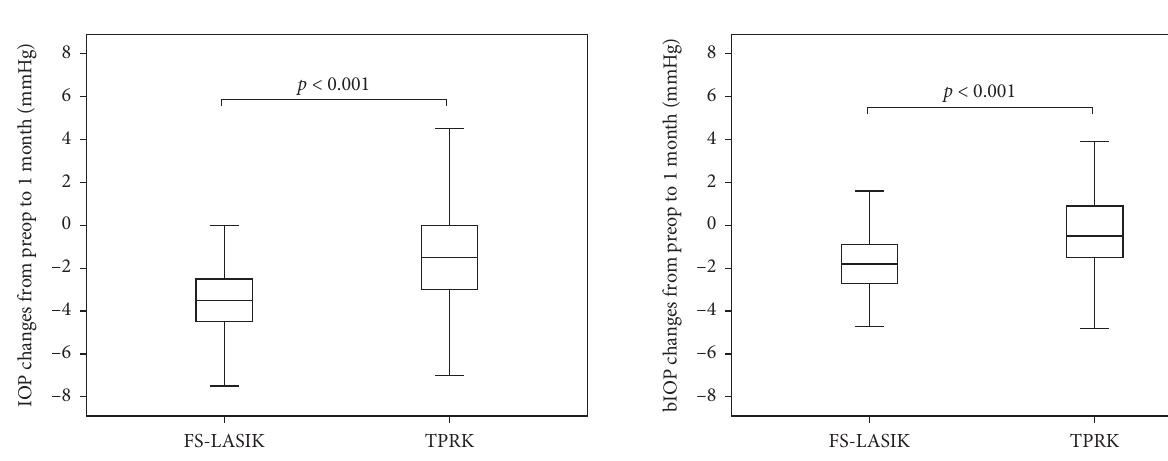
Figure 2: Box plot of biomechanically corrected intraocular pressure (bIOP) changes from before surgery to 1 month after transepithelial photorefractive keratectomy (TPRK) and femto- second laser in situ keratomileusis (FS-LASIK). The bottom and top of each box represent the lower and upper quartiles, respectively. The line inside each box represents the median. The bars represent data within 1.5 times the interquartile range. Reductions in bIOP after FS-LASIK were 1.64mmHg more than those after TPRK, after adjusting for